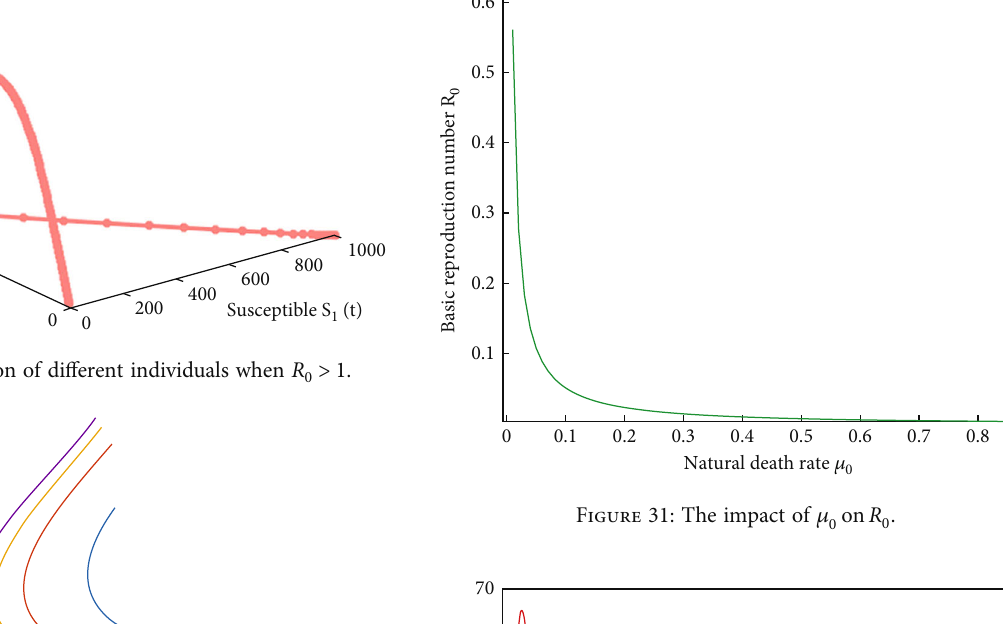
Figure 31: The impact of μ